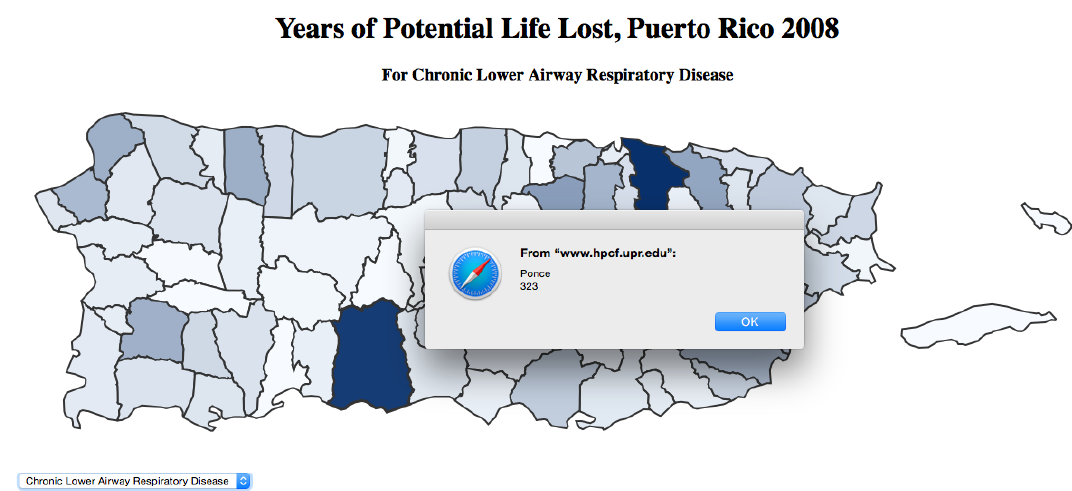
Figure 3. Screenshot of the SalHUD demo application showing the total YPLL for Chronic Lower Respiratory Airway Disease in the municipality of Ponce in 2008.